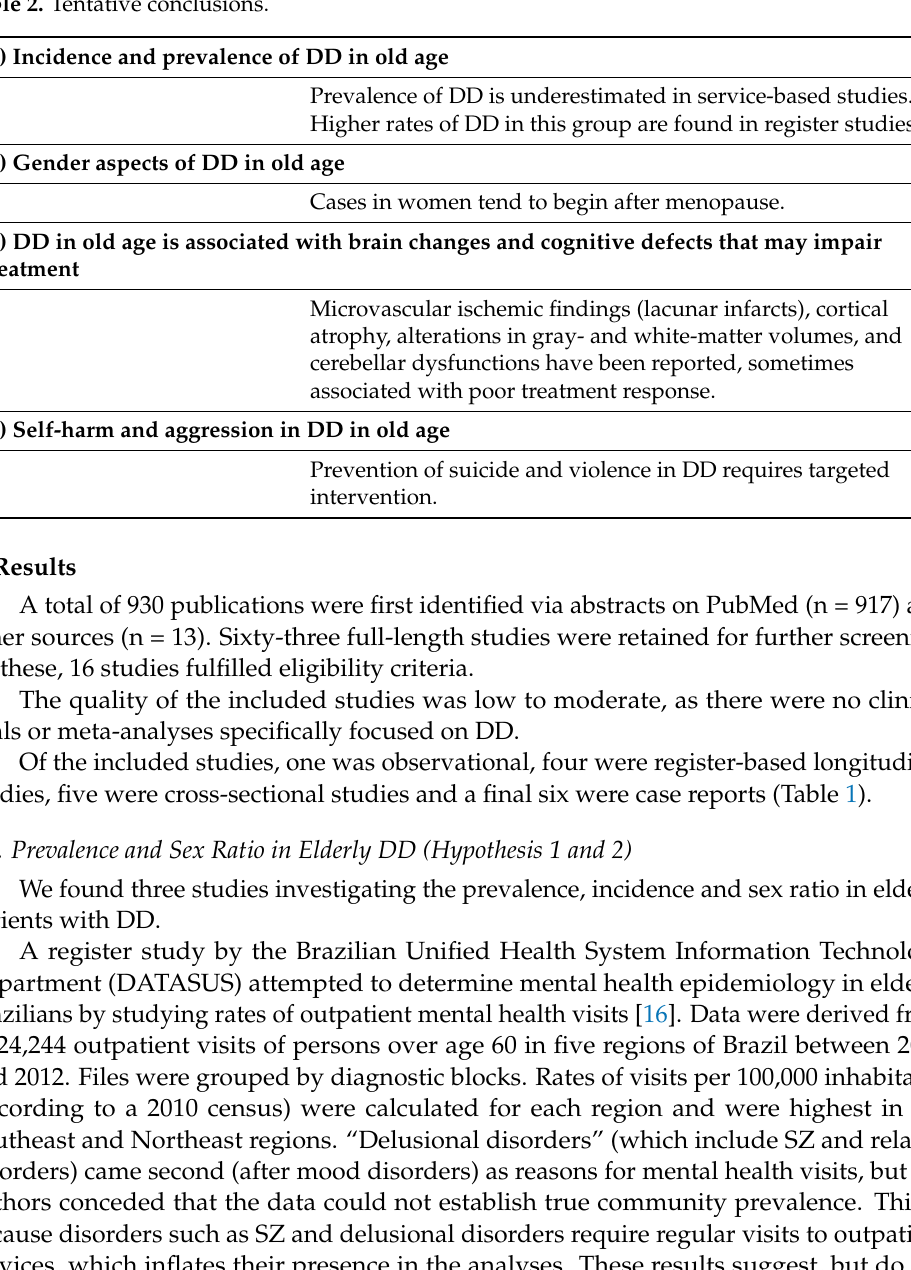
Table 2. Tentative